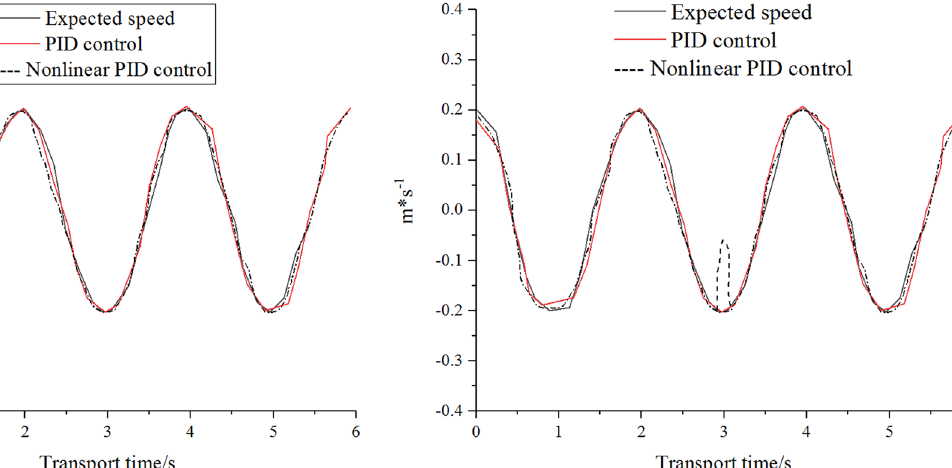
Figure 2: Response curve of plug velocity ( without load interference ) .